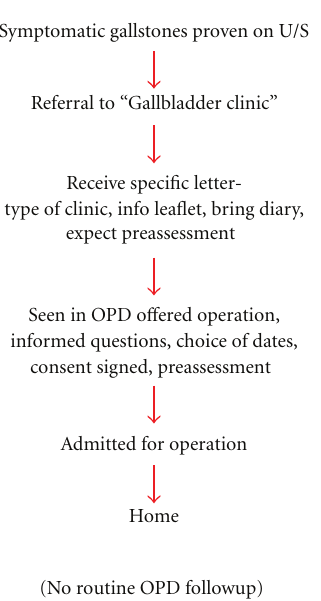
Figure 1: Pre-existing gallbladder patient pathway prior to 2006.